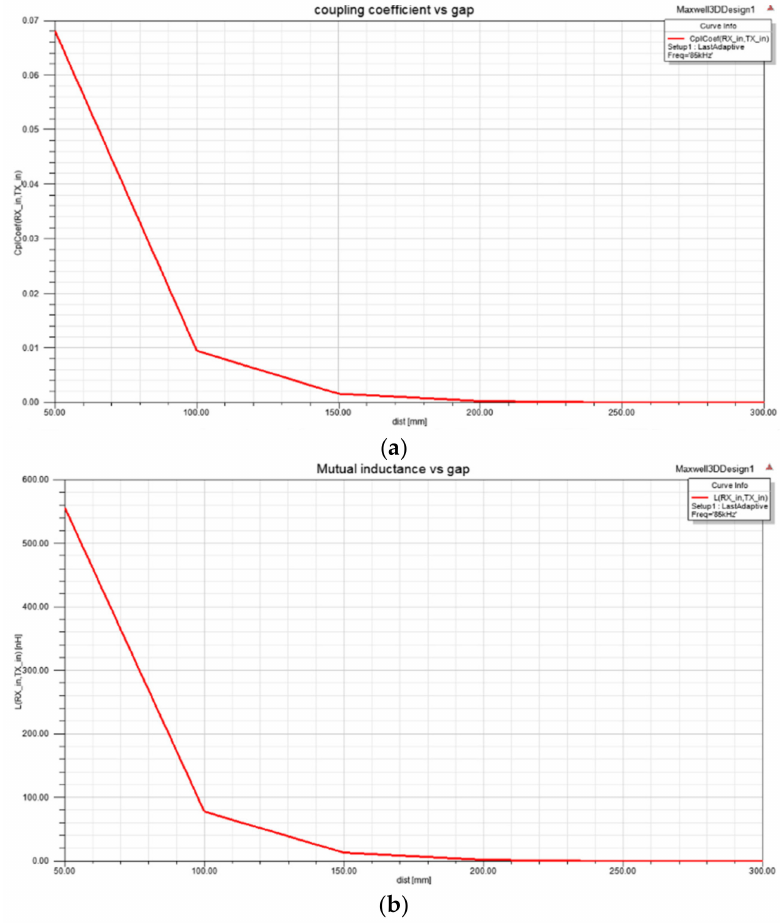
Figure 7. Rectangular coreless model: ( a ) coupling coefficient versus the gap variation, ( b ) mutual inductance versus the gap